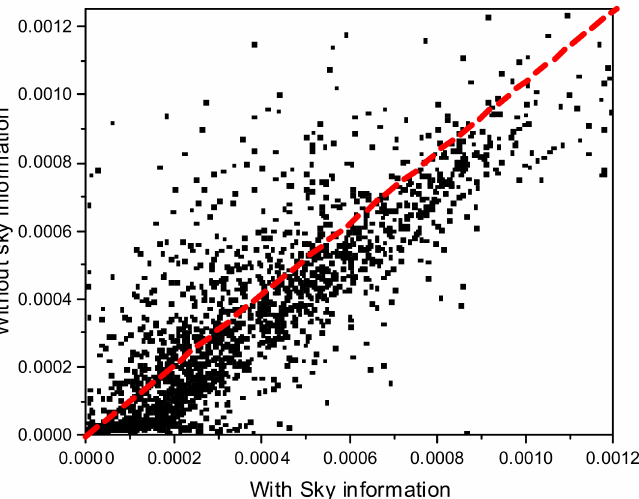
Figure 4. Correlation of the extinction coefficients between two cases. The x-axis represents the extinction coefficients measured with the present far distant sky objects and the y-axis represents the sky image assuming that the sky object is located at a distance of 10